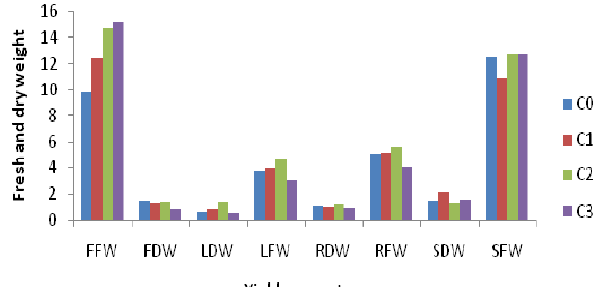
Fig. 2. Main effect of compost application on the yield parameters of two cultivars of okra in the pot experiment The values are the mean of the two maize varieties under different compost rates; C0- Control; C1 = 5 t/ha; C2 = 10 t/ha; C3 = 15 t/ha; FFW = Fresh Fruit Weight; FDW = Fruit Dry Weight; LDW = Leaf Dry Weight; LFW = Leaf Fresh Weight; RDW = Root Dry Weight; RFW = Root Fresh Weight; SDW = Stem Dry Weight; SFW = Stem